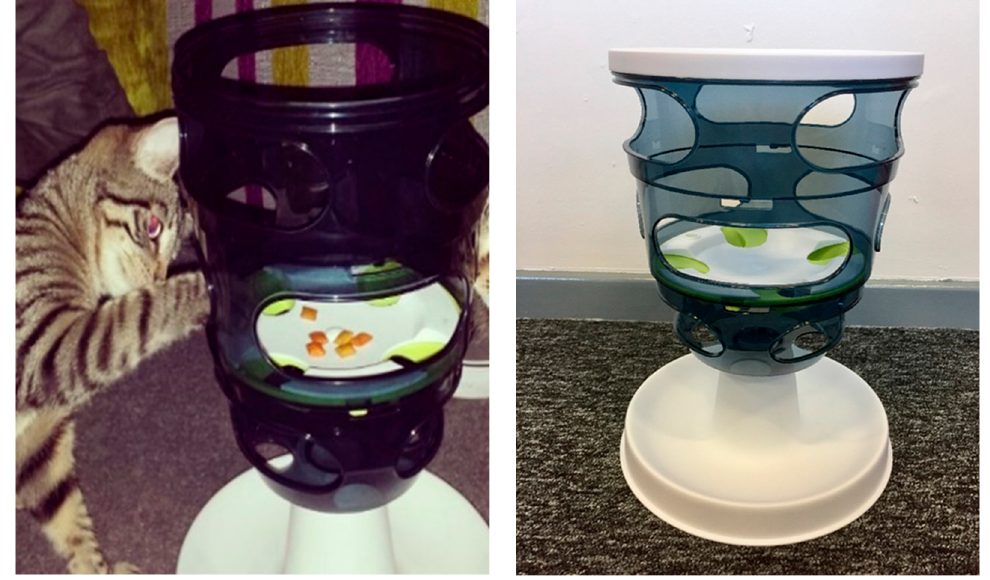
Figure 1. The Catit Senses Food Maze used to assess paw preferences.